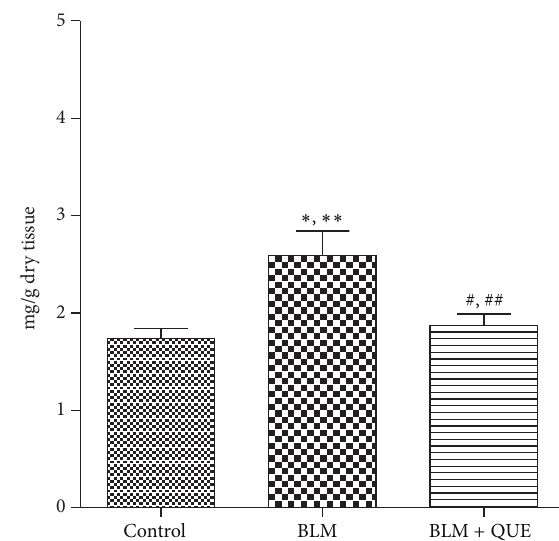
Figure 3: Hydroxyproline content in lung tissue on day 21 of treatment. 𝑛 = 6 . ∗ 𝑃 ≤ 0.05 , ∗∗ 𝑃 ≤ 0.01 versus control group. # 𝑃 ≤ 0.05 , ## 𝑃 ≤ 0.01 versus bleomycin